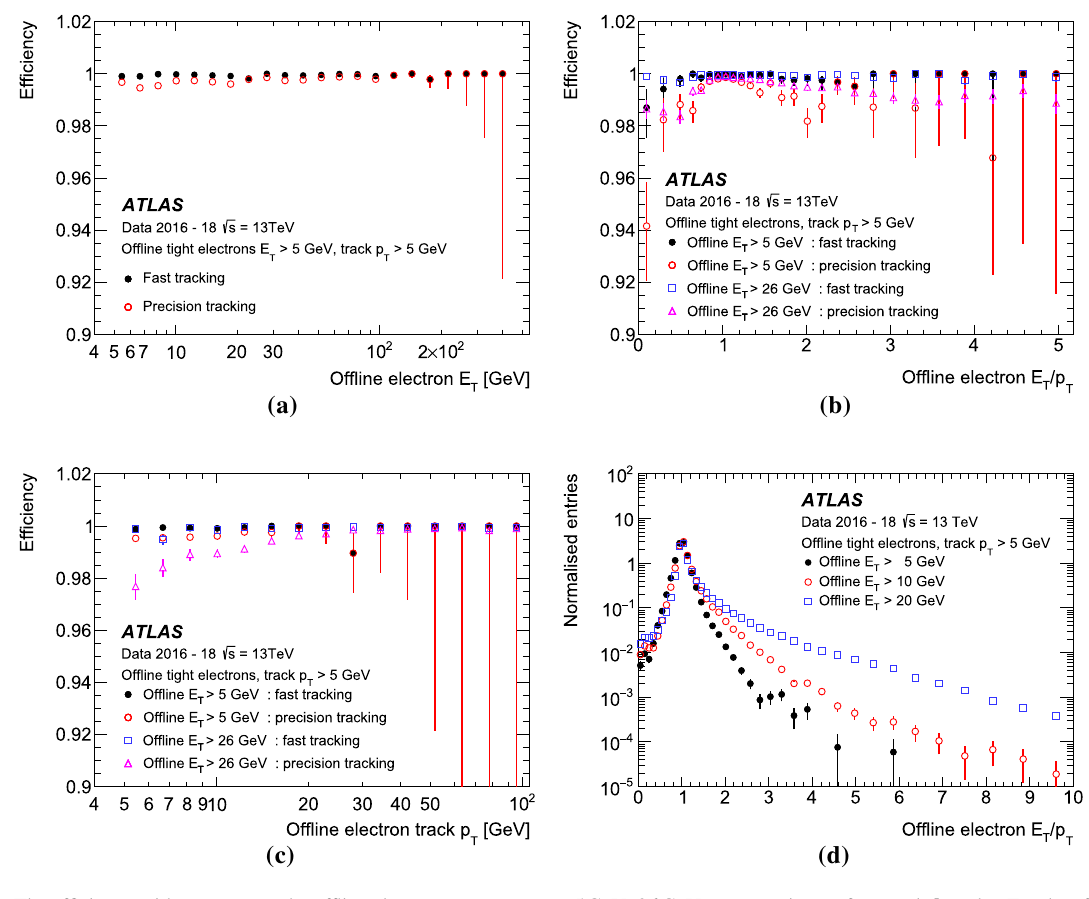
5GeV, 26GeV support triggers for panels b and c . For the efficiencies versus offline electron candidate E T and p T , only candidates where E T / p T > 0 . 8 are used. Statistical Bayesian uncertainties are shown, using a 68.3% confidence interval and uniform beta function prior